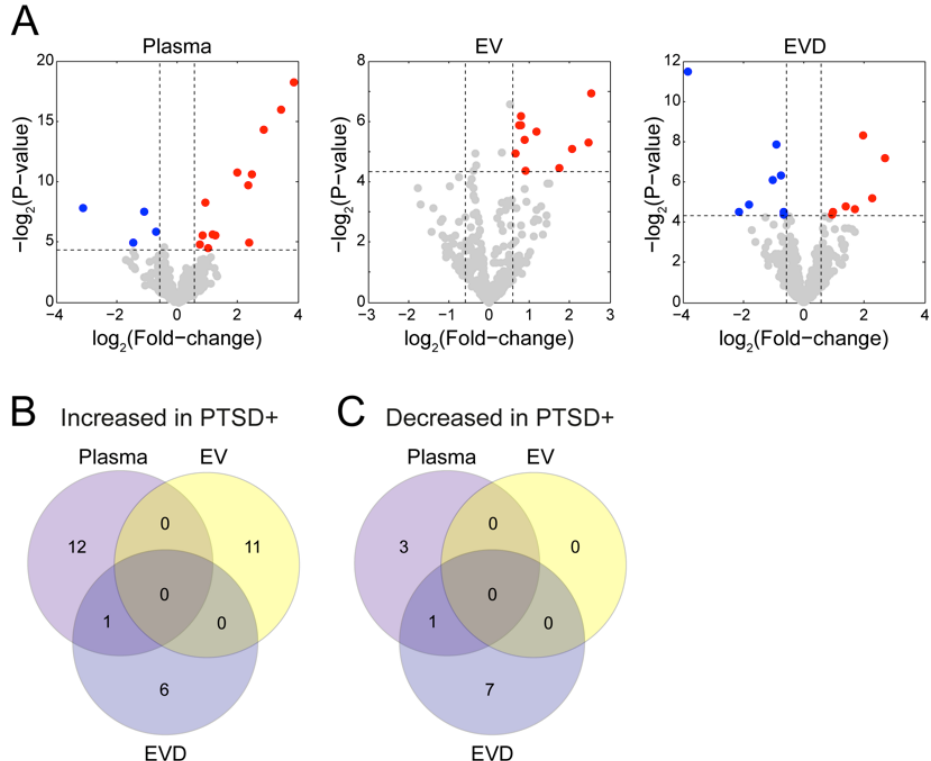
Figure 2. Differential abundances of the miRNAs between post-traumatic stress disorder- (PTSD-) and PTSD + subjects in three fractions. ( A ) Red and blue dots indicate higher- and lower-abundance miRNAs in PTSD + subjects. ( B ) The number of the increased miRNAs in PTSD + subjects. ( C ) The number of the decreased miRNAs in PTSD + subjects.